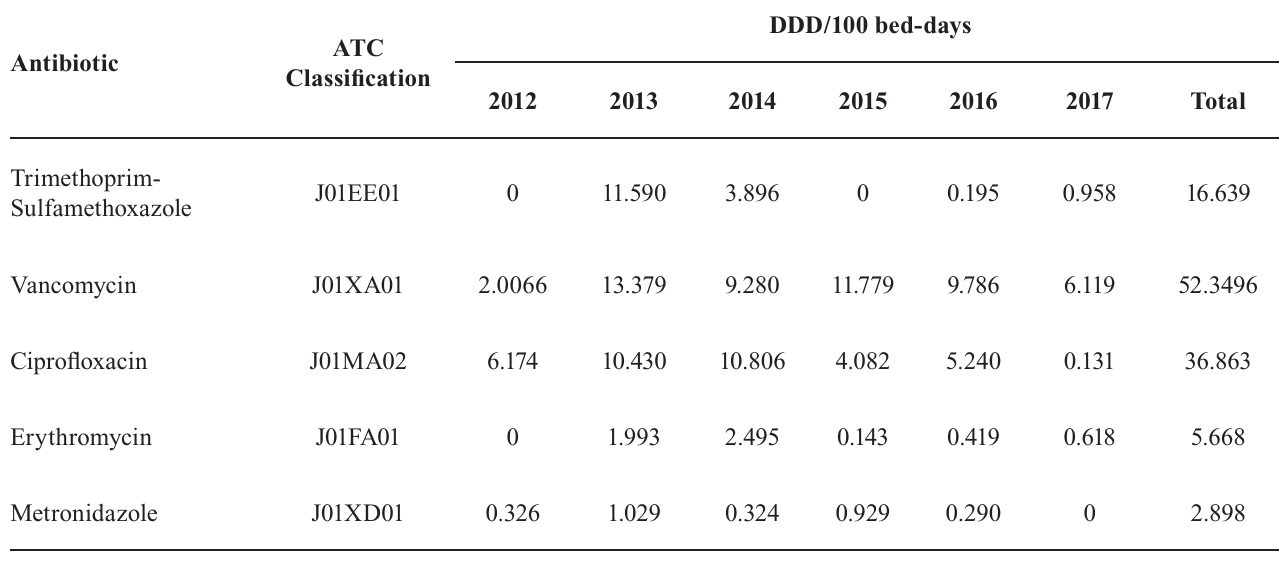
TABLE I - MKN45 xenograft tumors on day 12 after initial treatment (Volume & Net weight)